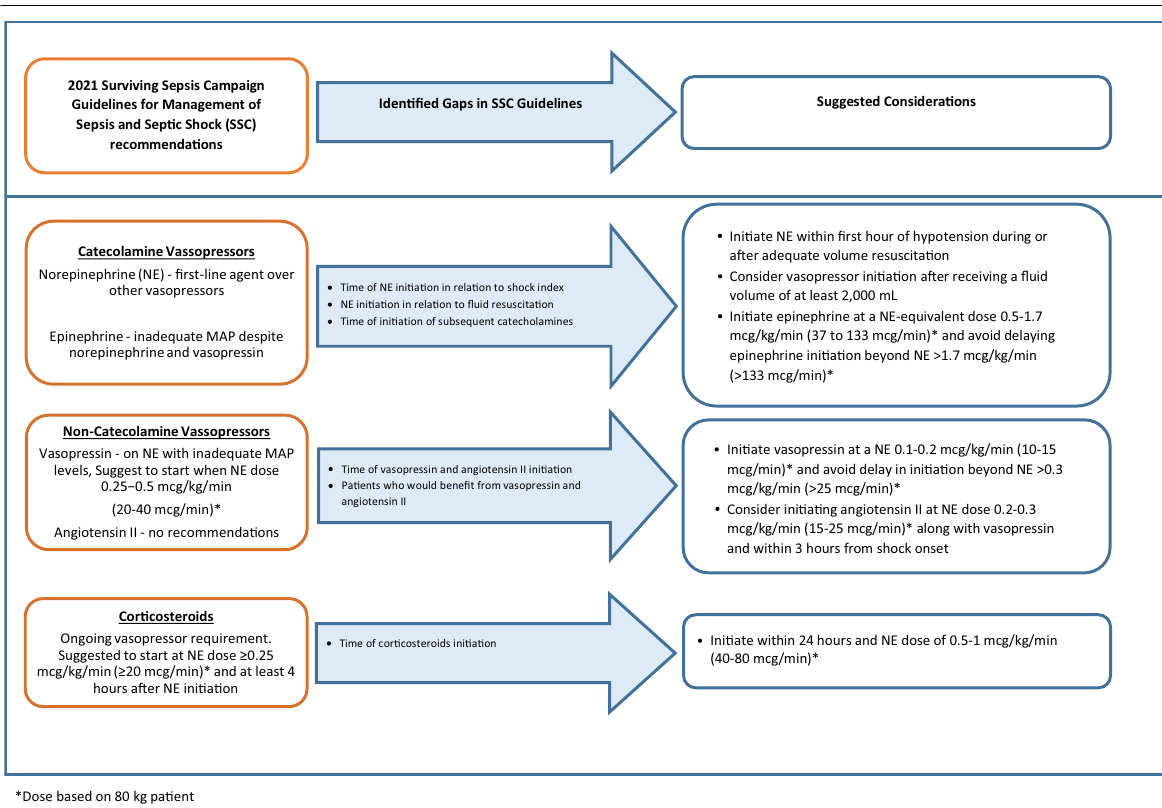
Fig. 1 Identified gaps in the Surviving Sepsis Campaign Guidelines for Management of Sepsis and Septic Shock (SSC) regarding initiation of vasoactive therapies and corticosteroids and suggested considerations for appropriate initiation of